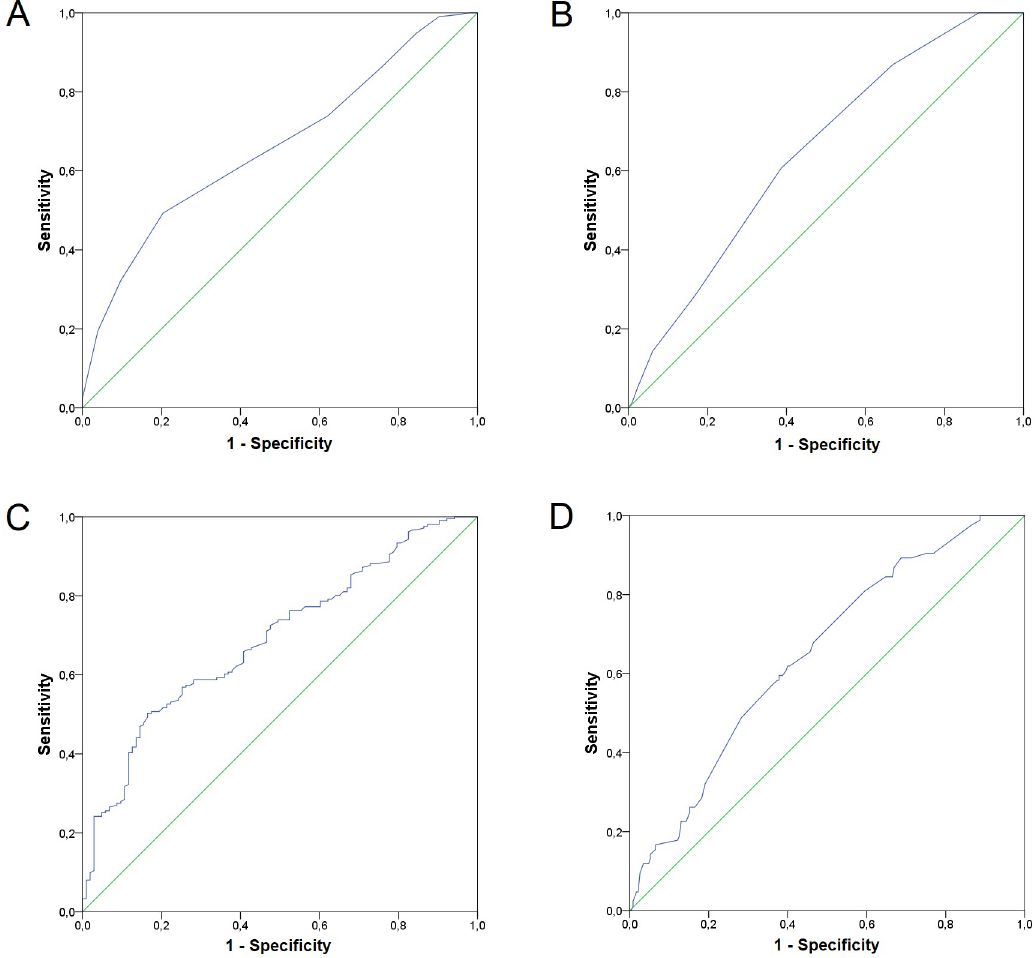
Fig 4. Receiver operating characteristics (ROC) curves for calculated genetic longevity scores. The ROC curve and area-under- curve (AUC) score for: A) uGLS90 (AUC = 0.662), B) uGLS95 (AUC = 0.649), C) wGLS90 (AUC = 0.690), D) wGLS95 (AUC = 0.649).